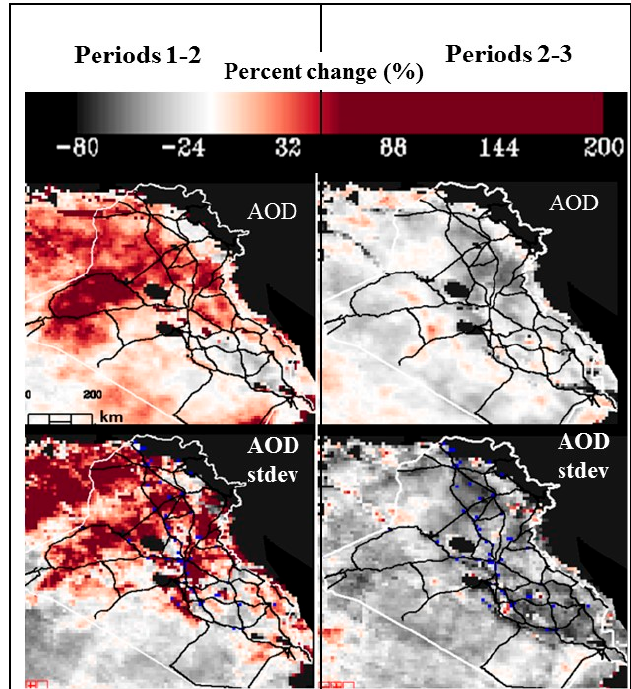
Figure 8. Percent change in AOD (top row) and AOD stdev (bottom row) in winter between Periods 1 and 2 ( left ) and 2 and 3 ( right ). Blue pixels are military sites. Reddish colors indicate increase whereas black and grey indicate decrease. Period 1: 1 March 2000–19 March 2003 (before OIF); Period 2: 20 March 2003–31 December 2011 (presence of US forces); Period 3: 1 January 2012–31 December 2018 (post-war). Table 3. Same as Table 2 but estimated for Iraq. Similarly, the largest change is during the winter and fall periods, which are characterized by a lower amount of dust storms compared to spring and summer. a.